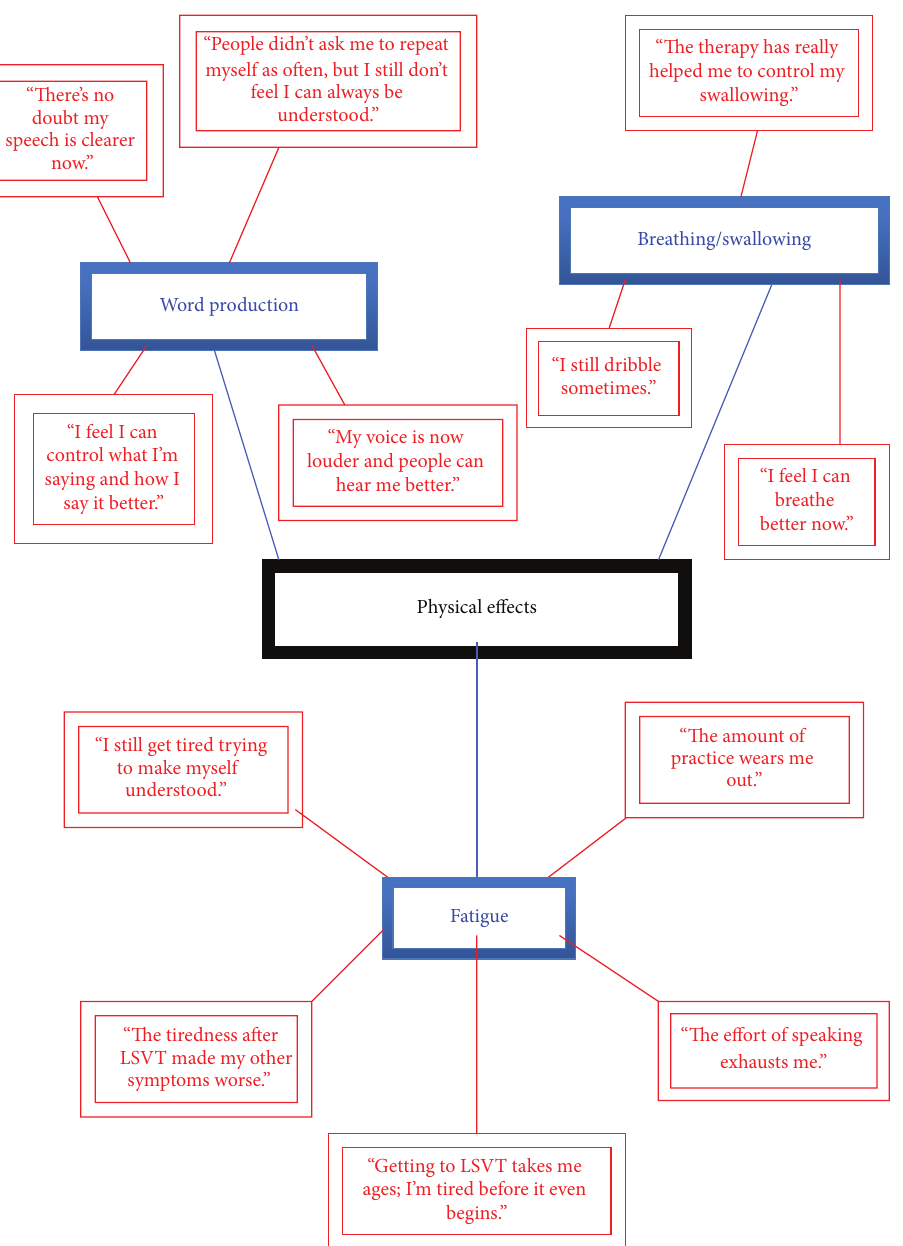
Figure 2: Thematic Network Analysis: physical